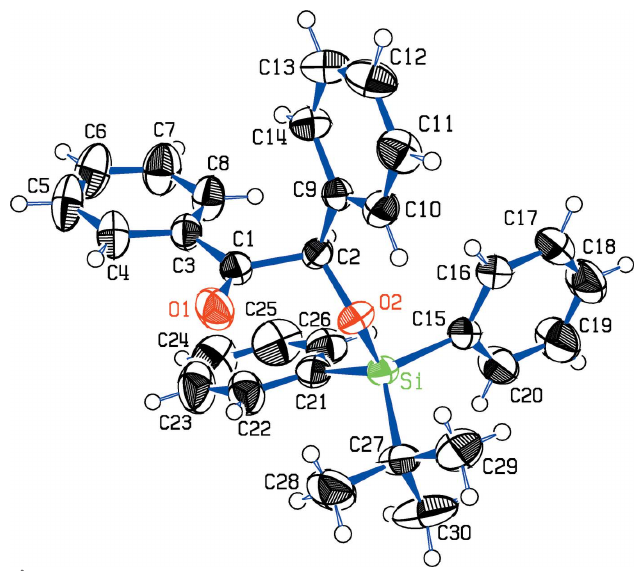
Figure 1 The molecular structure of the title compound. Displacement ellipsoids are drawn at the 50% probability level. Displacement parameters for the H atoms are